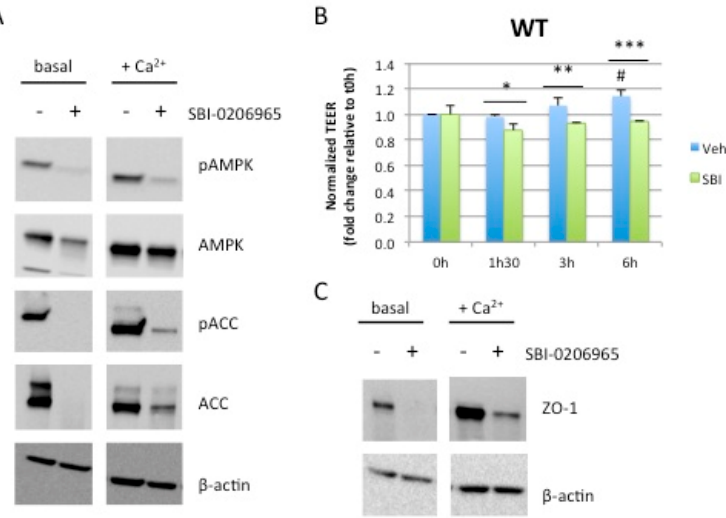
Figure 4. Acute pharmacological inhibition of AMPK prevents establishment of TEER after